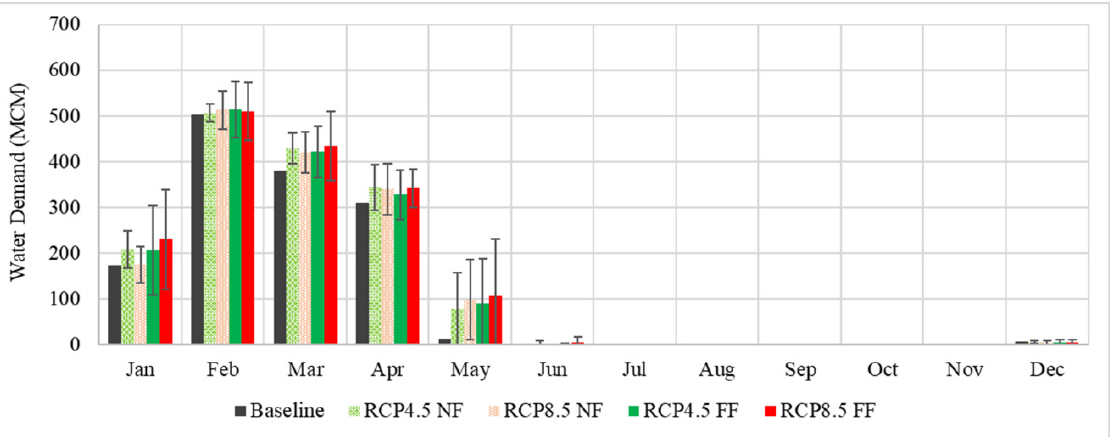
Figure 13. Agricultural water demands in the SRB. Error bars in the figure show a standard deviation between the GCMs.